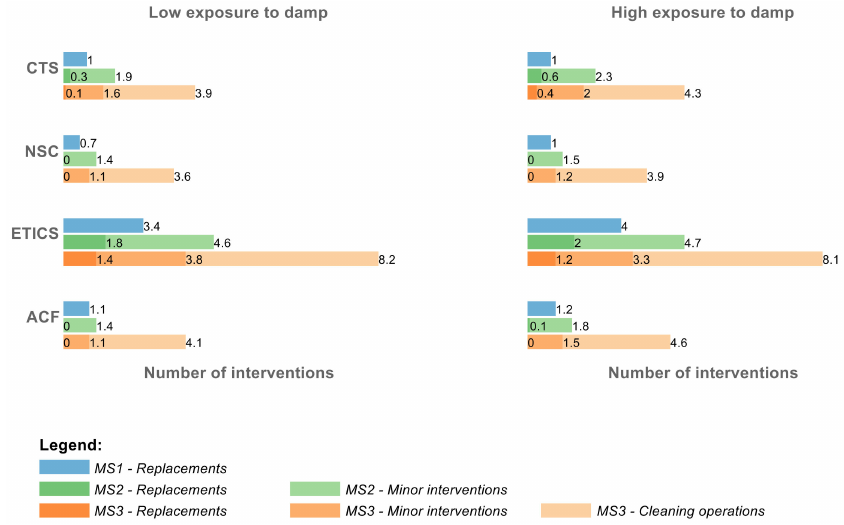
Figure 6. Comparison of the number of interventions according to exposure to damp for a time horizon of 80 years.